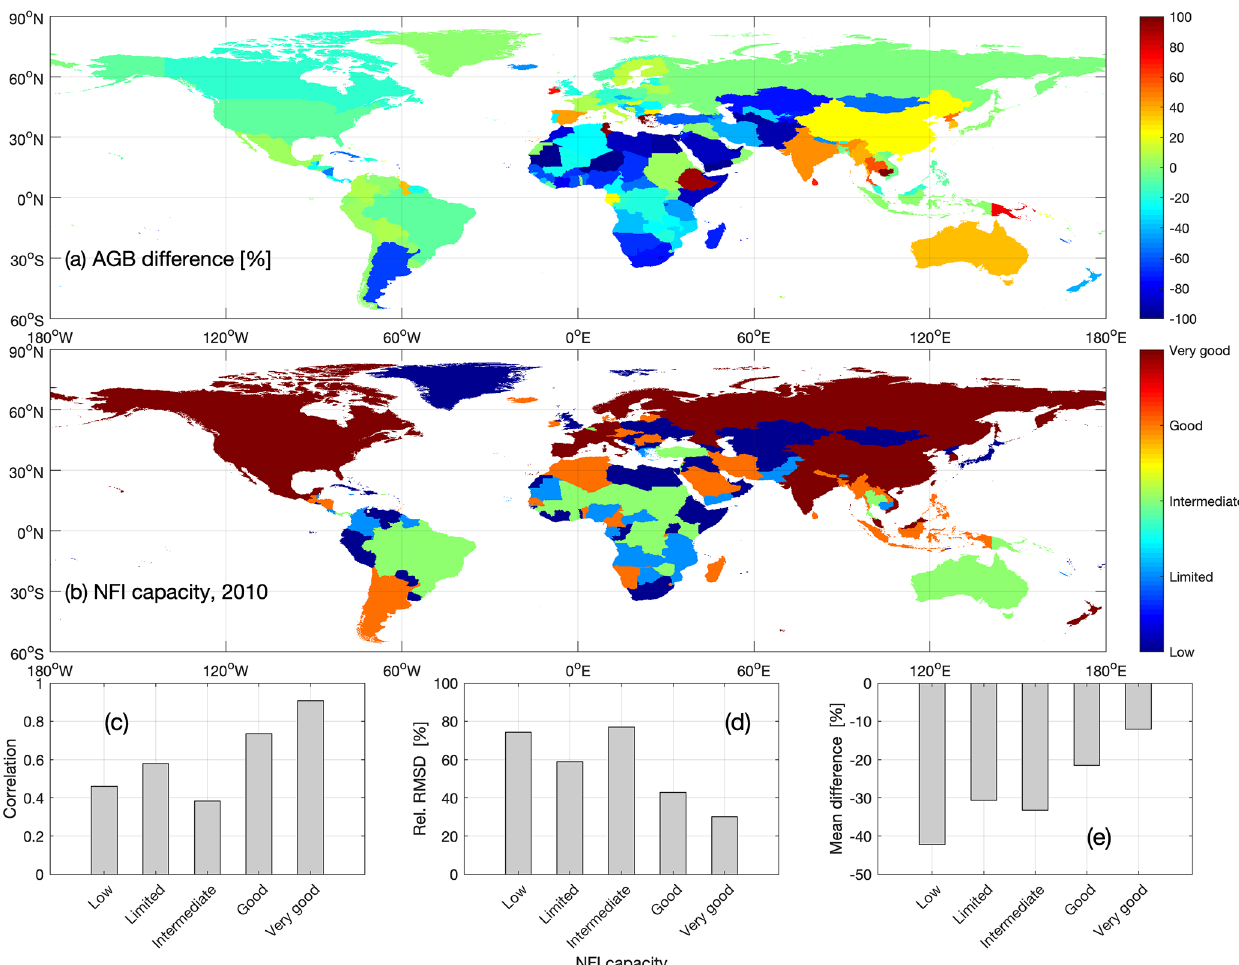
Figure 8. Difference between country AGB from our map and FRA (expressed relative to the FRA AGB) (a) , NFI capacities for the year 2010 (Romijn et al., 2015) (b) , Pearson’s correlation coefficient (c) , relative RMSD (d) , and mean difference between map estimates of country AGB and values from the FRA for NFI capacity level (e) . Number of countries per NFI capacity level: 51 (low), 30 (limited), 26 (intermediate), 37 (good), and 23 (very